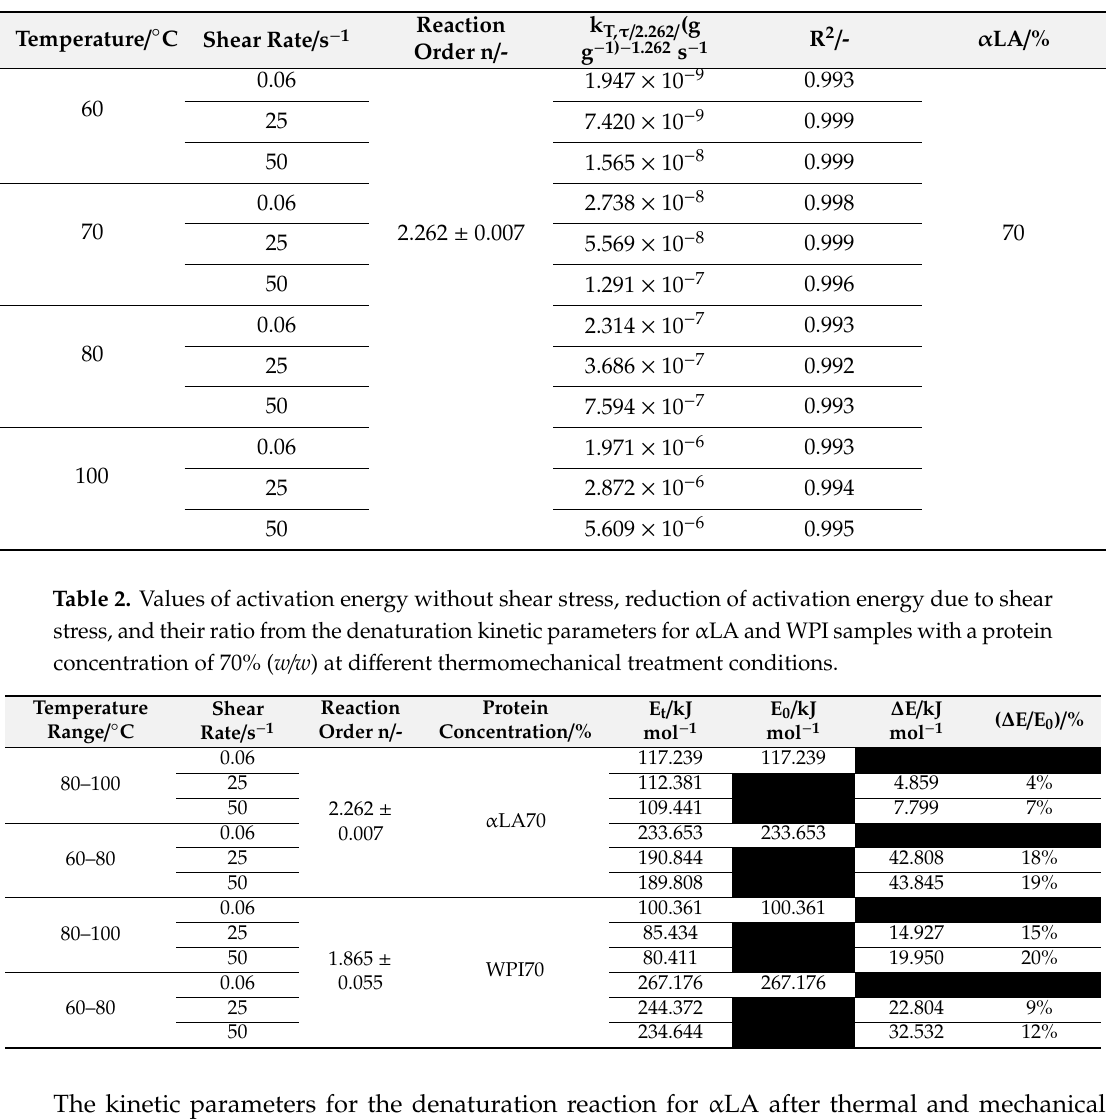
Table 1. Denaturation kinetic parameters for α LA at a concentration of 70%.